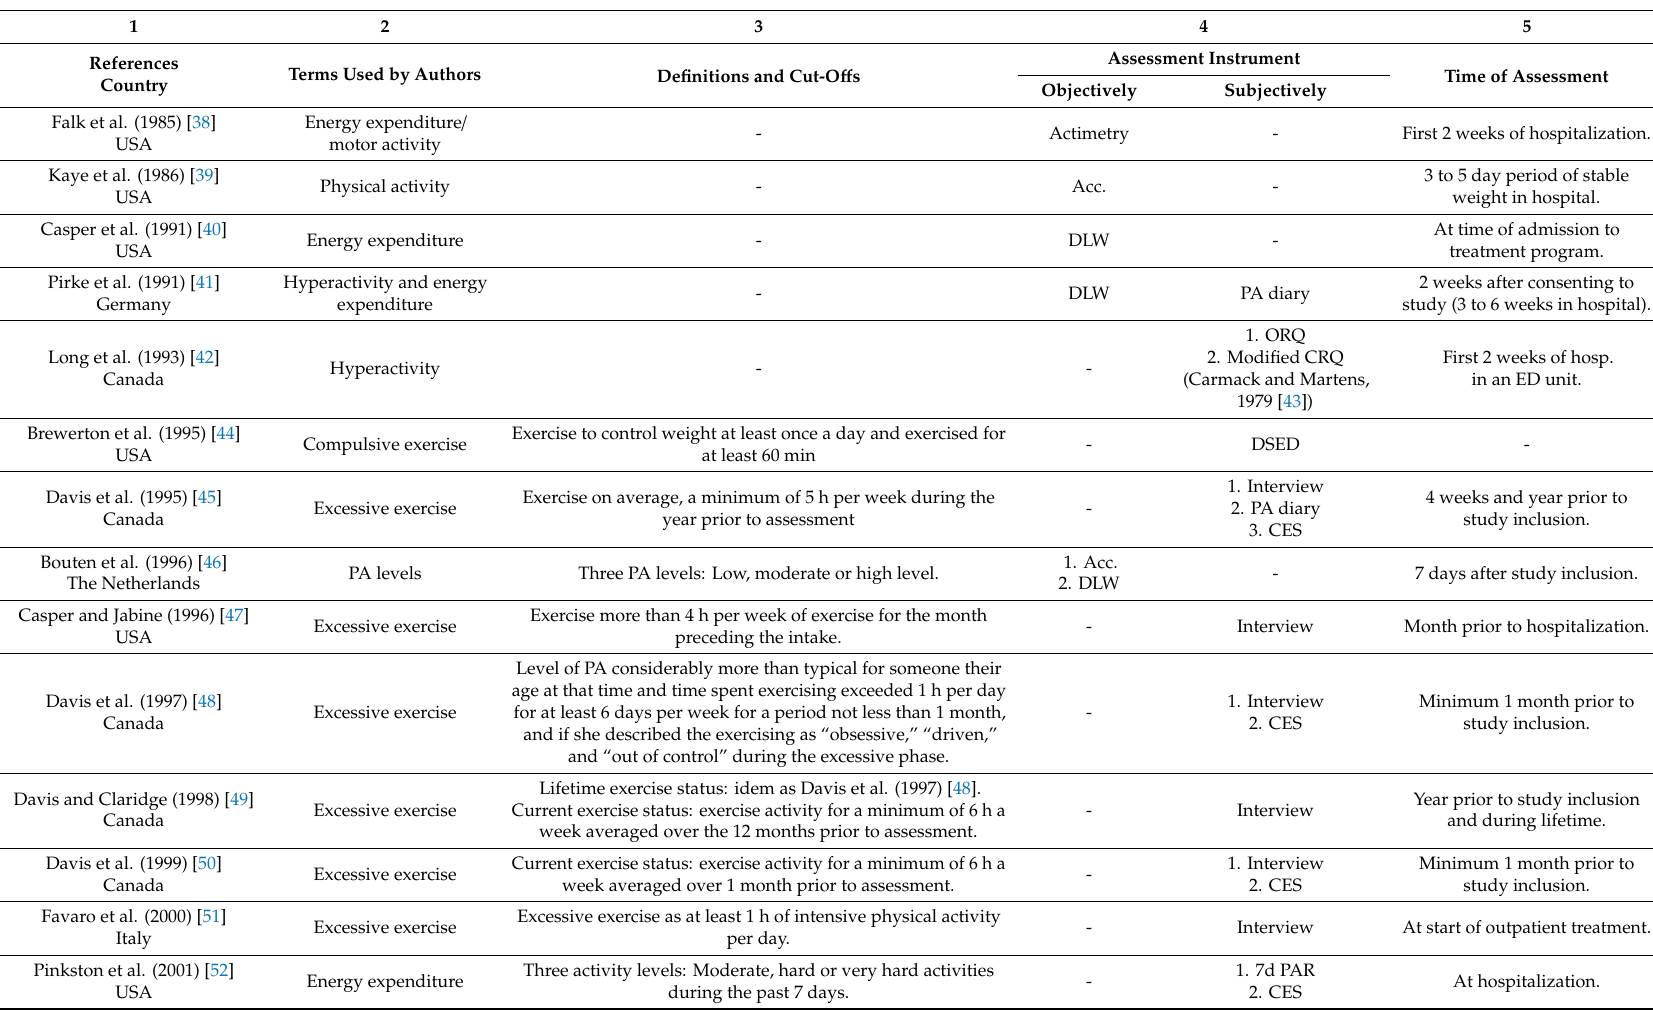
Table 1. Terms used by authors, definitions, cut-o ff s, assessment instruments and time of assessment of problematic use of physical activity in ED (columns 1 to